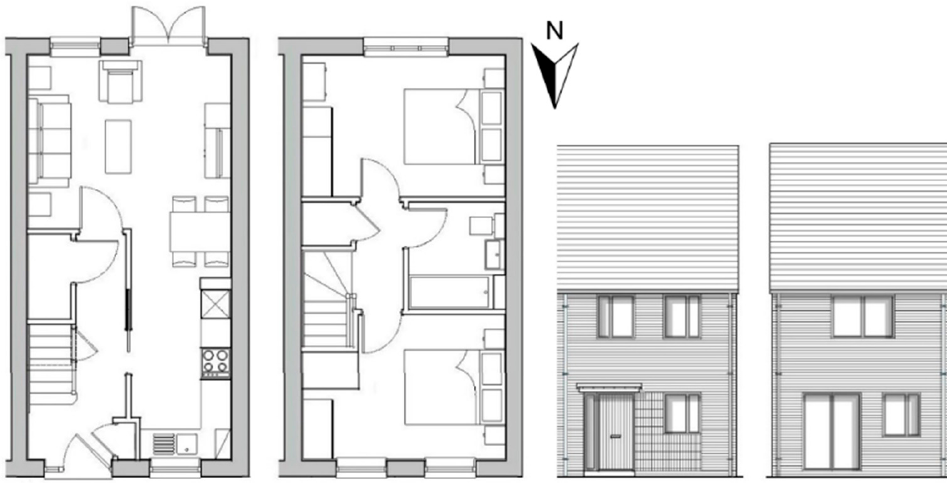
Figure 3. Ground and first floor layout, front and rear elevations of generic house; semi-detached form (other forms the same except for adjacency of other similar homes with party walls between).